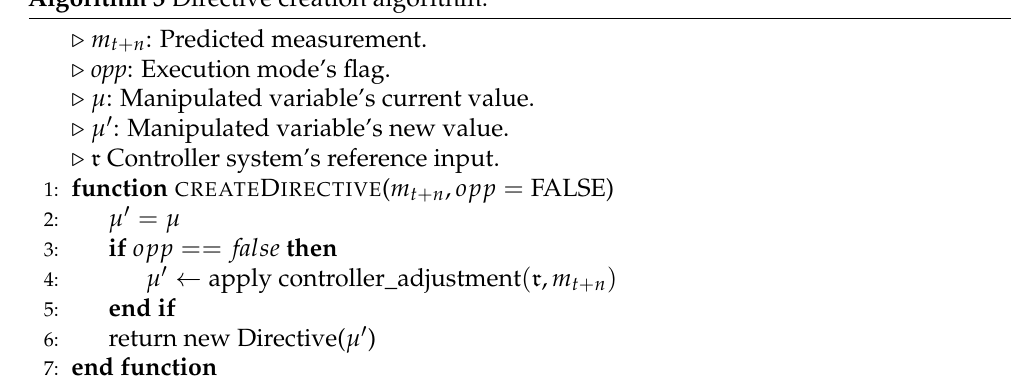
Algorithm 3 Directive creation